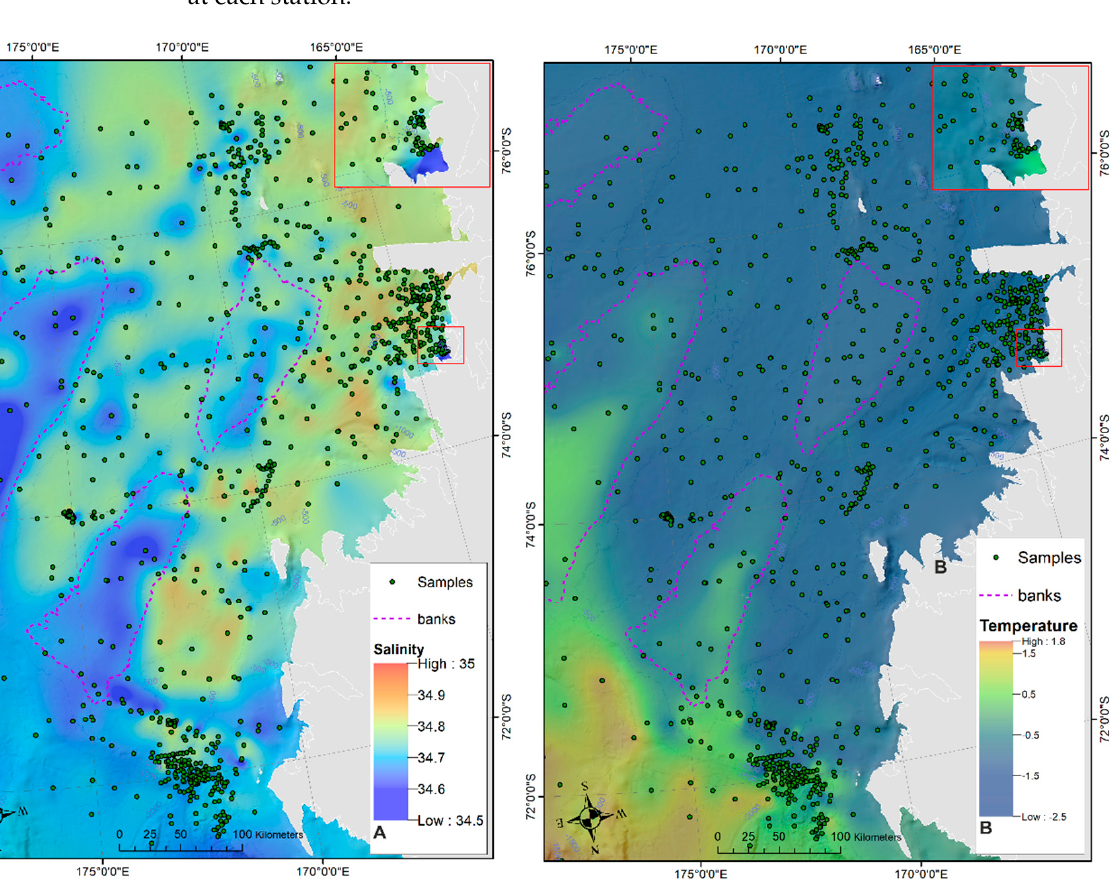
Figure 2. GIS predictive salinity ( A ) and temperature ( B ) distribution maps interpolated in GIS applying the spline method using barriers.